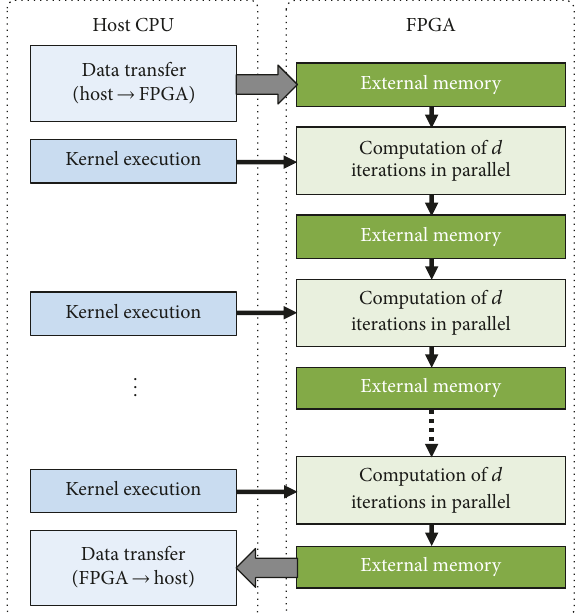
Figure 2: Flowchart of the computation. FPGA processes 𝑑 itera- tions in parallel.